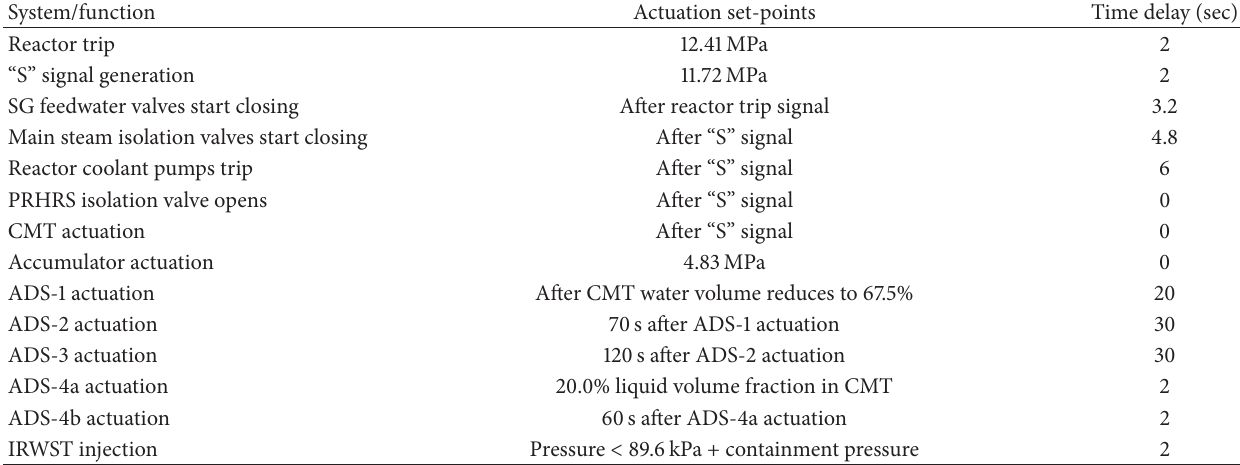
Table 1: Actuation set-points and time delay assumption considered for AP1000 LOCA [4].